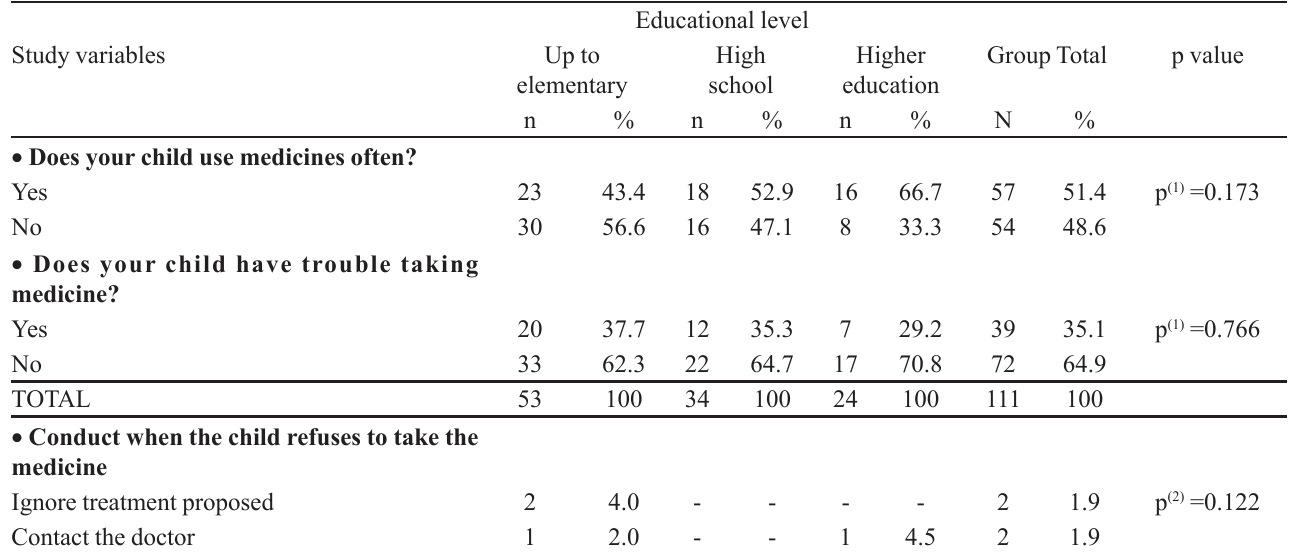
TABLE III - Evaluation of issues on “Maternal Knowledge about Use of Pediatric Medicines” by educational level of mothers